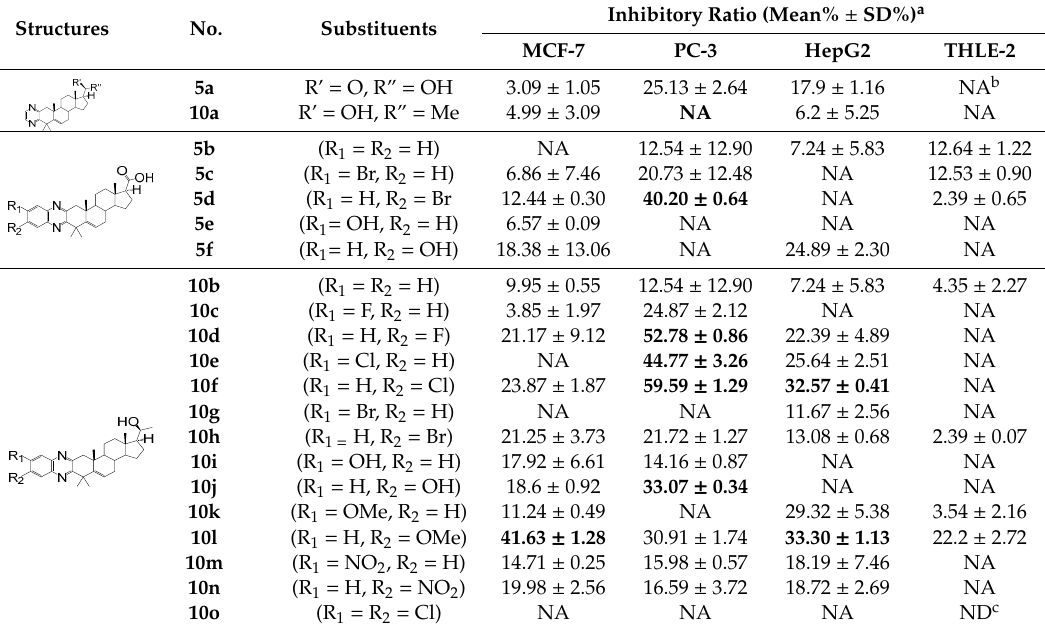
Table 1. Inhibitory activity of the derivatives of 5a–f , 10a–o , and 12a–o in terms of the growth of three human cancer cell lines and one human normal cell line. Structures